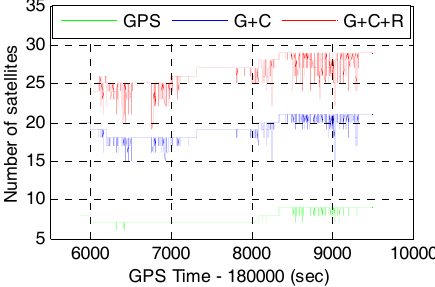
Figure 4. Number of satellites of GPS (G), GPS/BDS (G+C), GPS/BDS/GLONASS (G+C+R) with 15° cut-off elevation angle.